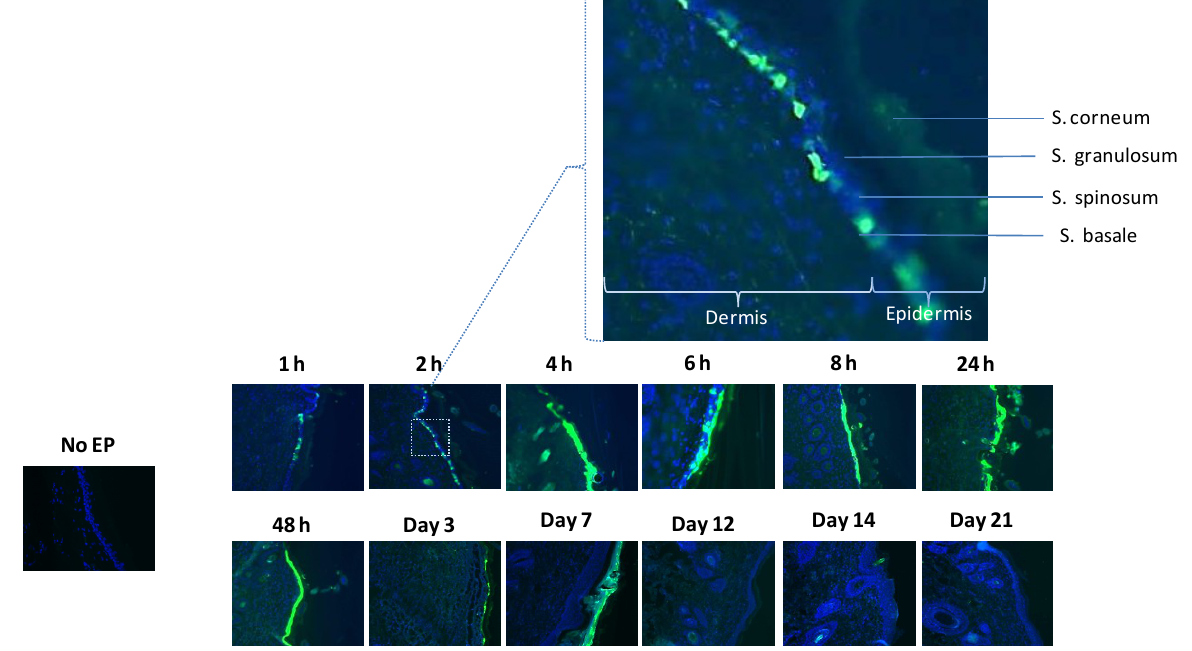
Figure 2. Histological analysis reveals rapid GFP expression. Histological analysis of GFP expression in a time course (1-hour post treatment to day 21) after ID plasmid administration followed by EP with SEP in guinea pig skin. Skin biopsies were removed, cryosectioned, DAPI stained and visualized under fluorescence microscopy (10×). An injection only control is also shown. Photos are representative examples of multiple treatments. A region of the 2-hour time point section image is enlarged to allow the annotation of skin